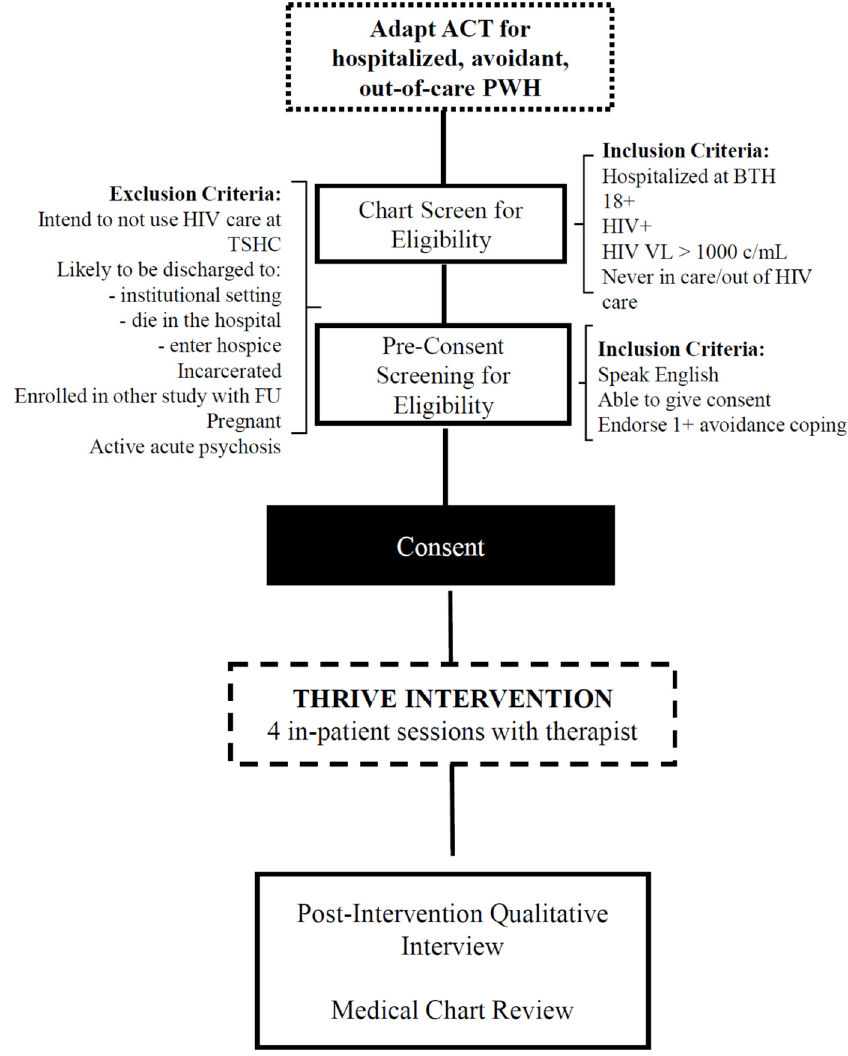
Figure 3. Summary of procedures.